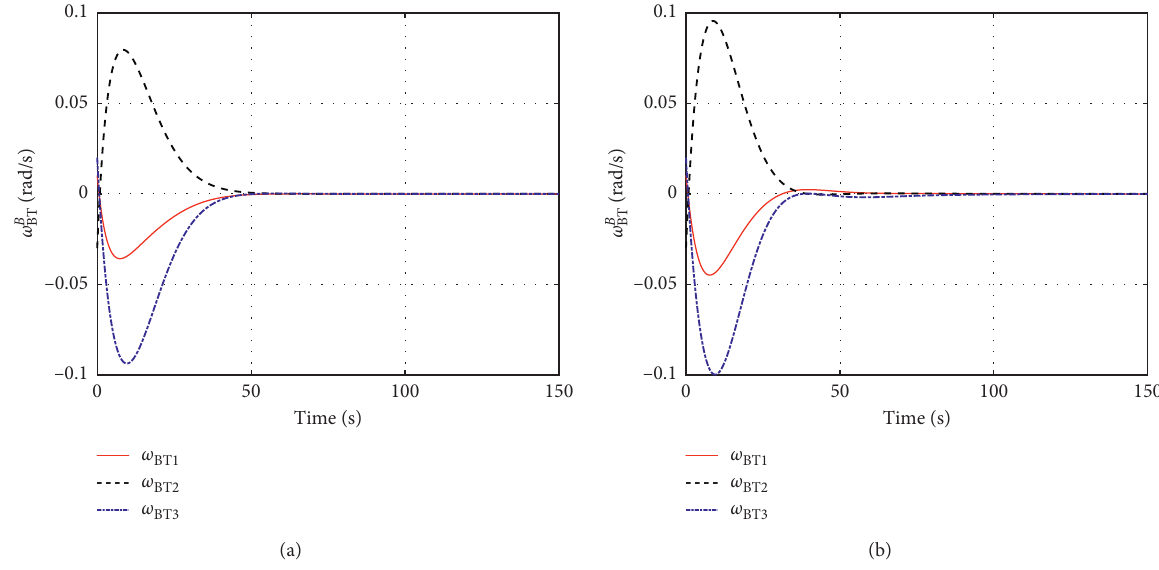
Figure 4: Relative angular velocity. (a) Proposed I&I adaptive controller. (b) CE-based adaptive